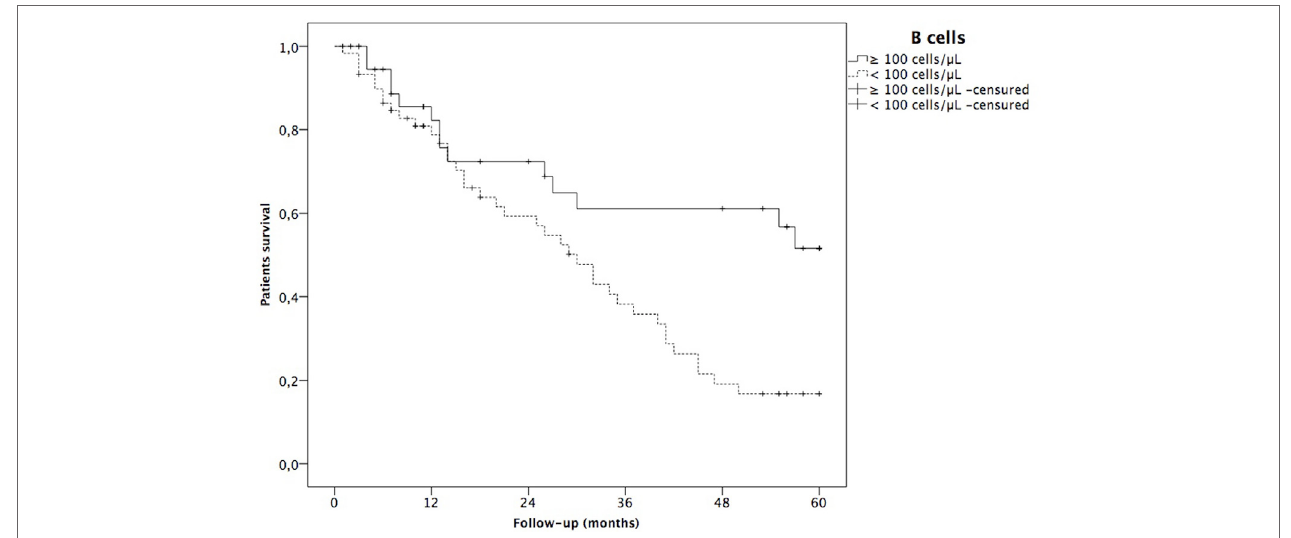
FigUre 3 | Kaplan–Meier survival curves for number of CD19 + B-cells ( < or ≥ 100 cells/ μ L) and global patient survival were analyzed with a log-rank test.